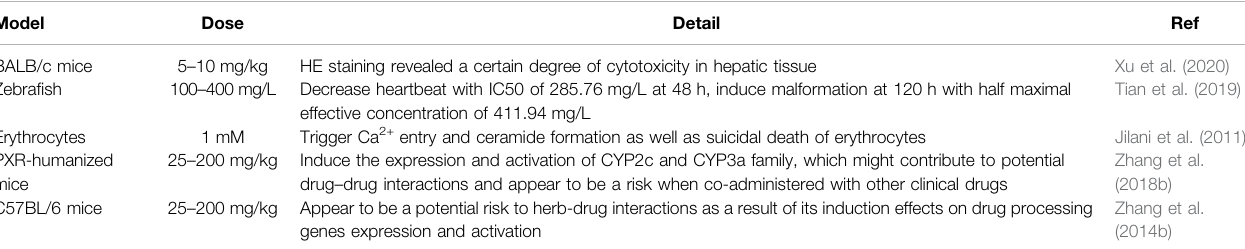
TABLE 3 | Toxicity researches of